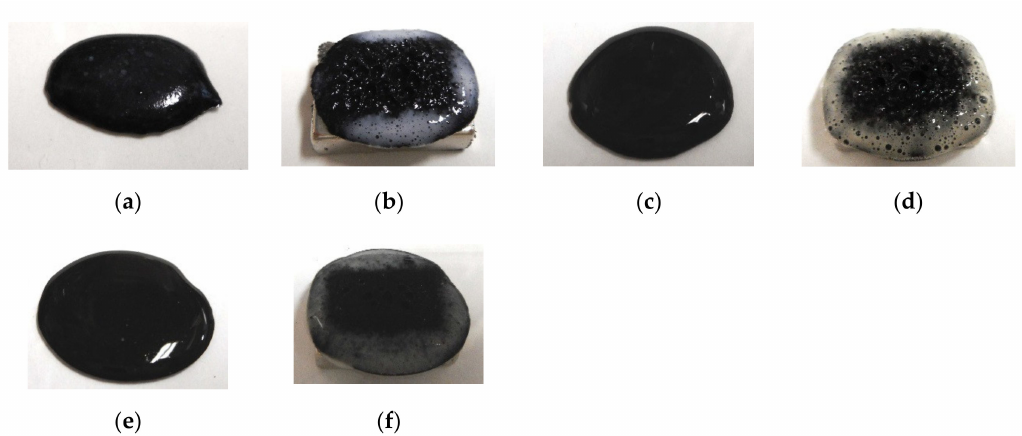
Figure 3. Images of liquid mixed with water-insoluble liquid and water: ( a ) kerosene mixed without a magnetic field; ( b ) kerosene mixed under a magnetic field; ( c ) alkyl naphthalene mixed without a magnetic field; ( d ) alkyl naphthalene mixed under a magnetic field; ( e ) para ffi n mixed without a magnetic field; ( f ) para ffi n mixed under a magnetic field.